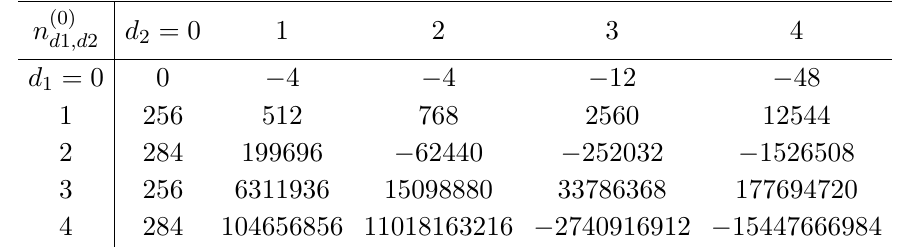
Table 4 . Genus zero Gopakumar-Vafa invariants that arise from the elliptic fibration with toric data (6.1) in the limit τ → 2 τ and m → τ . This corresponds to q parametrization (6.5).